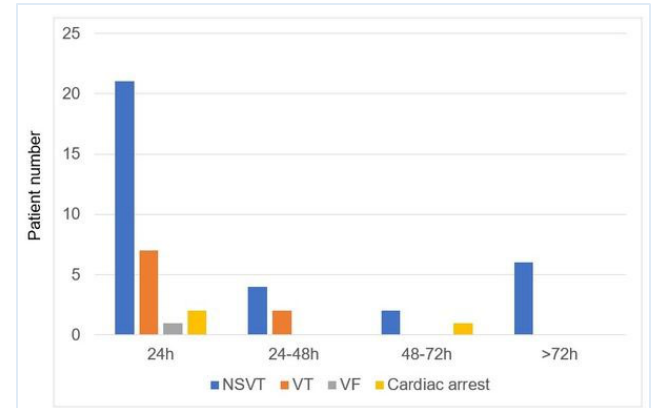
Figure Time course of severe arrhythmia during arrhythmia